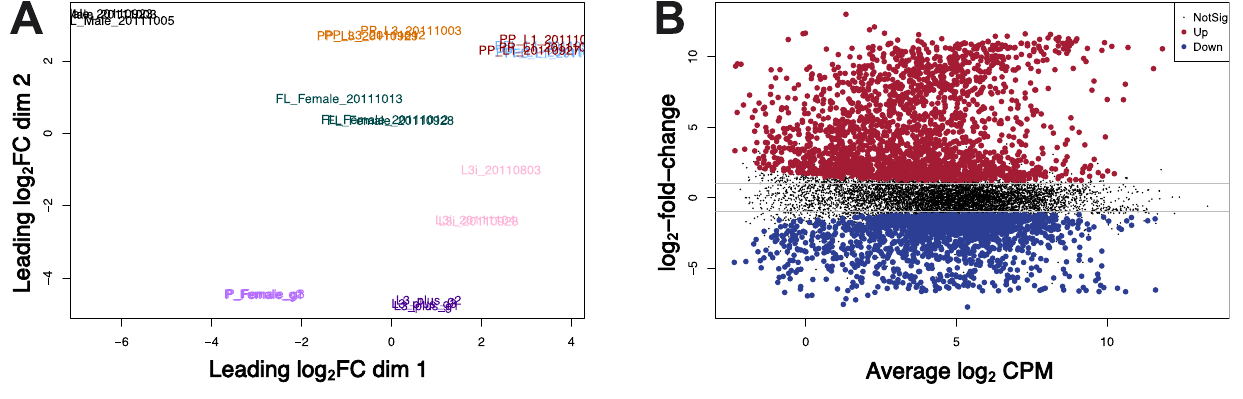
Figure 2. S. stercoralis developmental stages have distinct transcript expression profiles. ( A ) S. stercoralis developmental stages examined by RNA-Seq are well-separated, and the three biological replicates group closely, by multidimensional scaling (MDS) analysis. ( B ) Numerous transcripts are significantly (log 2 fold change > 1.0; FDR < 0.05) up-regulated (red) and down-regulated (blue) in free-living adult males, in comparison to free- living adult females, by mean-difference (MD) analysis. A subset of transcripts are significantly up-regulated in free-living adult males to a greater extent than transcripts are down-regulated. Plots were constructed using EdgeR